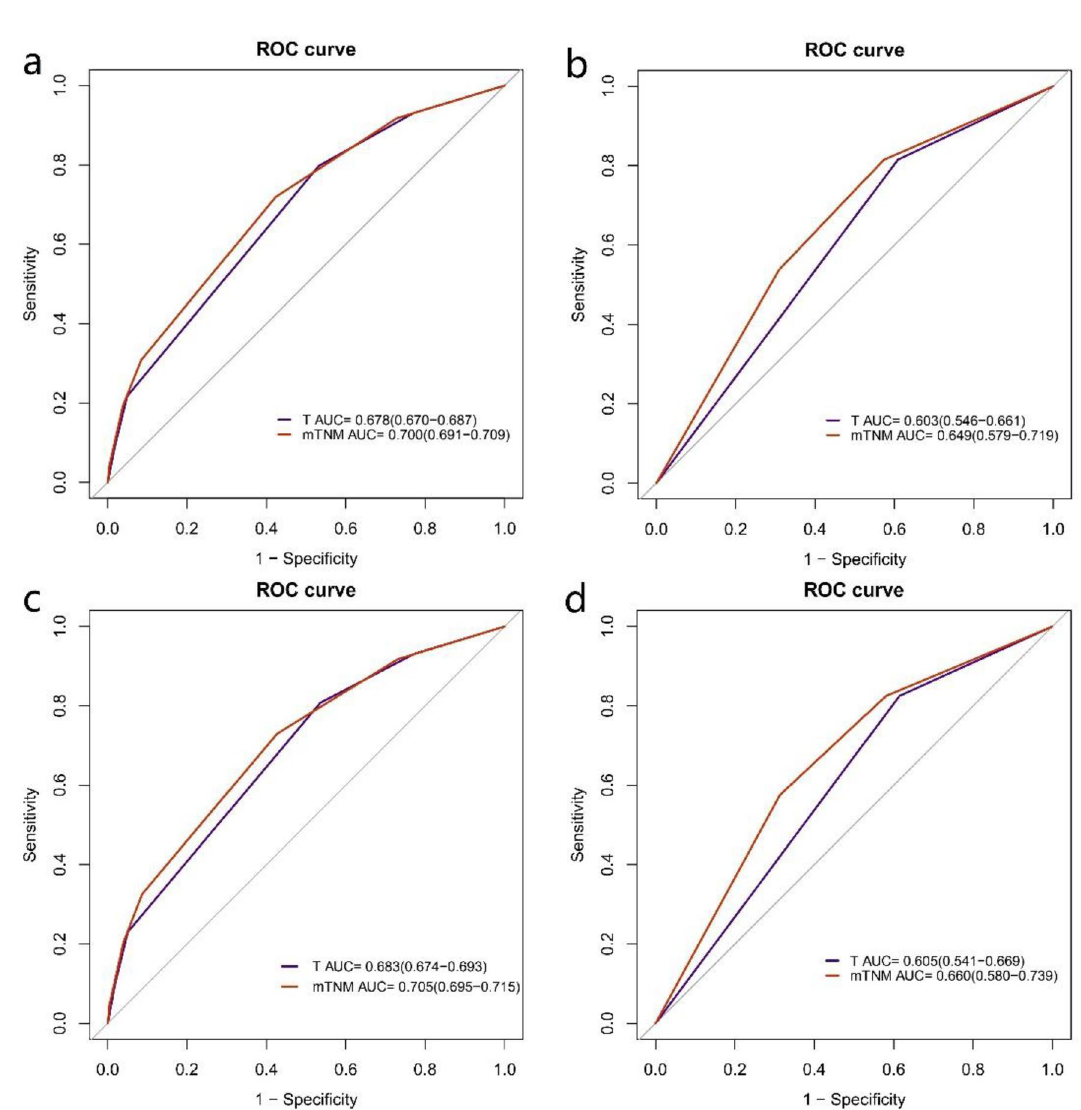
Figure 6. The AUCs of the mStage and conventional TNM stage. ( a ) Comparison of the 5-year AUCs in the development cohort. ( b ) Comparison of the 5-year AUCs in the validation cohort. ( c ) Comparison of the 3-year AUCs in the development cohort. ( d ) Comparison of the 3-year AUCs in the validation